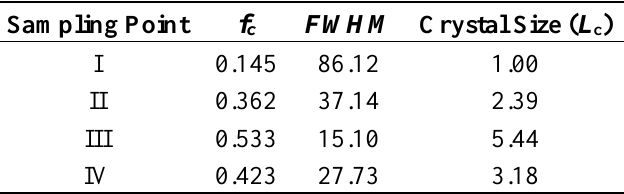
Table 4. Orientation and crystallite size for fibers spun into a 79.0 wt% DMAc/H 2 O coagulation bath obtained from